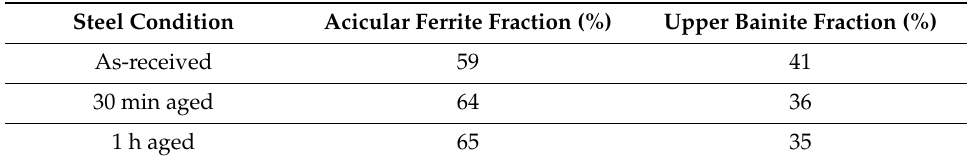
Figure 6. API X70 TEM micrographs: ( a ) as received pipeline steel TEM micrograph showing precipitation level, ( b ) 1 h aged steel specimen showing an increasing number and homogeneous precipitation distribution.